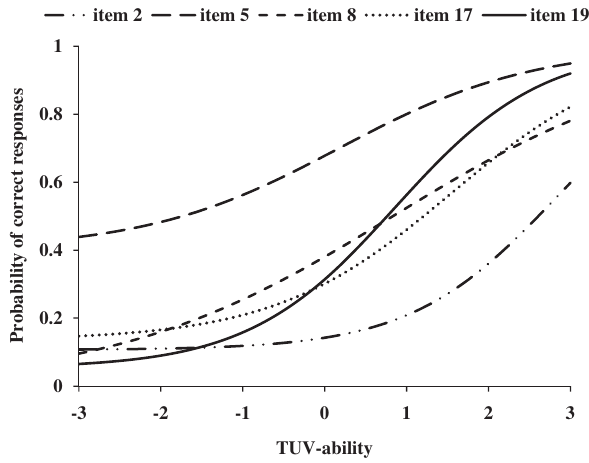
FIG. 3. The ICCs for items 2, 5, 8, 17, and 19 in the TUV, according to data on Thai